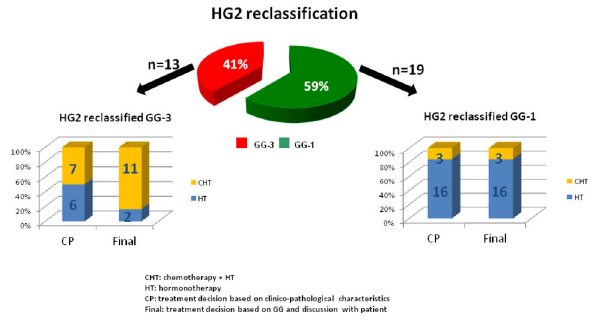
Figure 2. Impact of GGI reclassification on